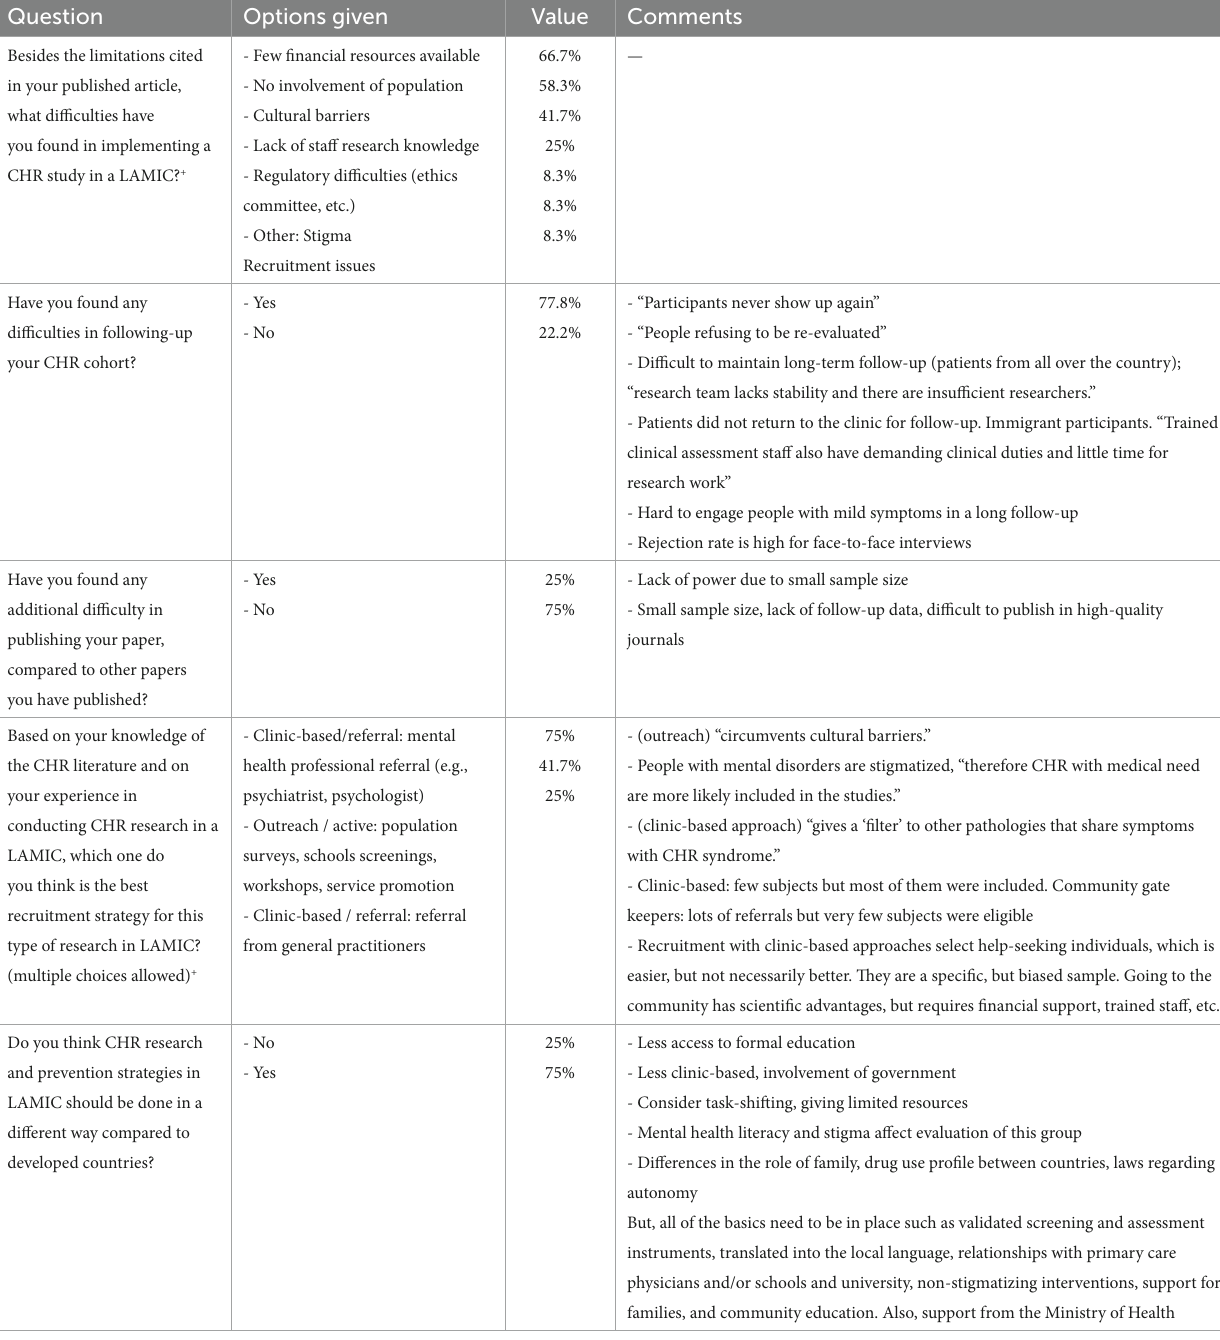
TABLE 3 Results of the online poll with corresponding